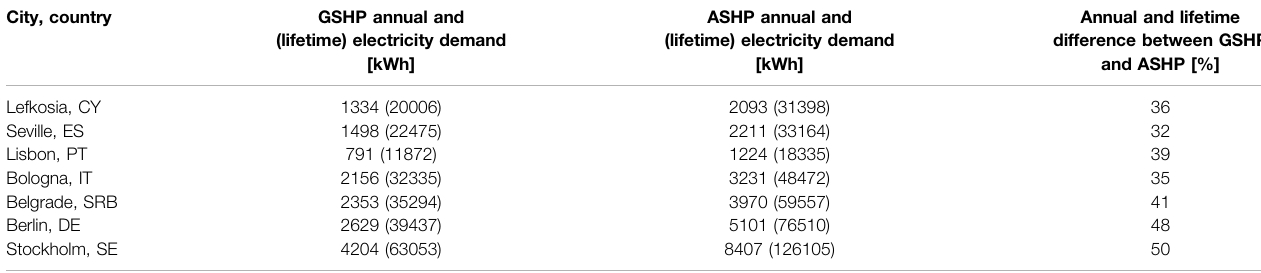
TABLE 2 | Annual and lifetime electricity demand of GSHP and ASHP systems. City, country